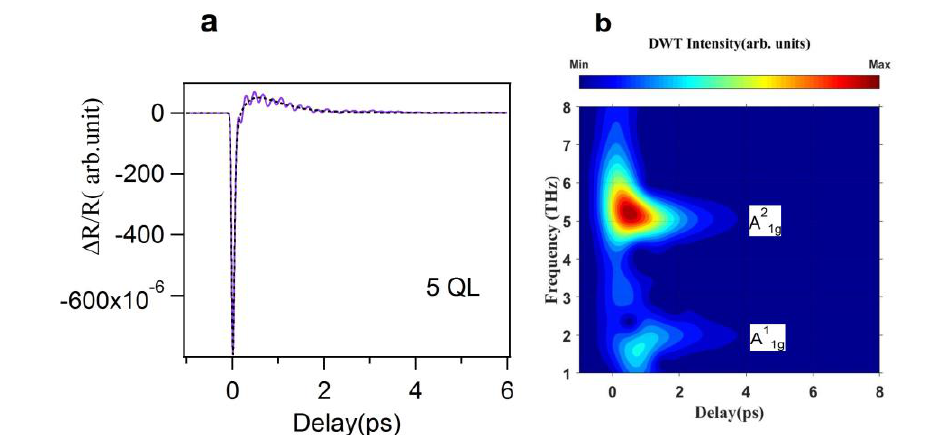
Fig. 1. (a) Time evolution of the reflectivity signal obtained for a 5 QL thick Sb 2 Te 3 TIs film. The non-oscillatory signal represents a background indicated by a dotted line, while oscillatory component is due to coherent phonons. (b) The coherent phonon spectrum in time and frequency domain obtained based on the DWT analysis performed on the residual oscillatory signal. The two dominant phonon modes assigned to A 1g1 and A 1g2 ,